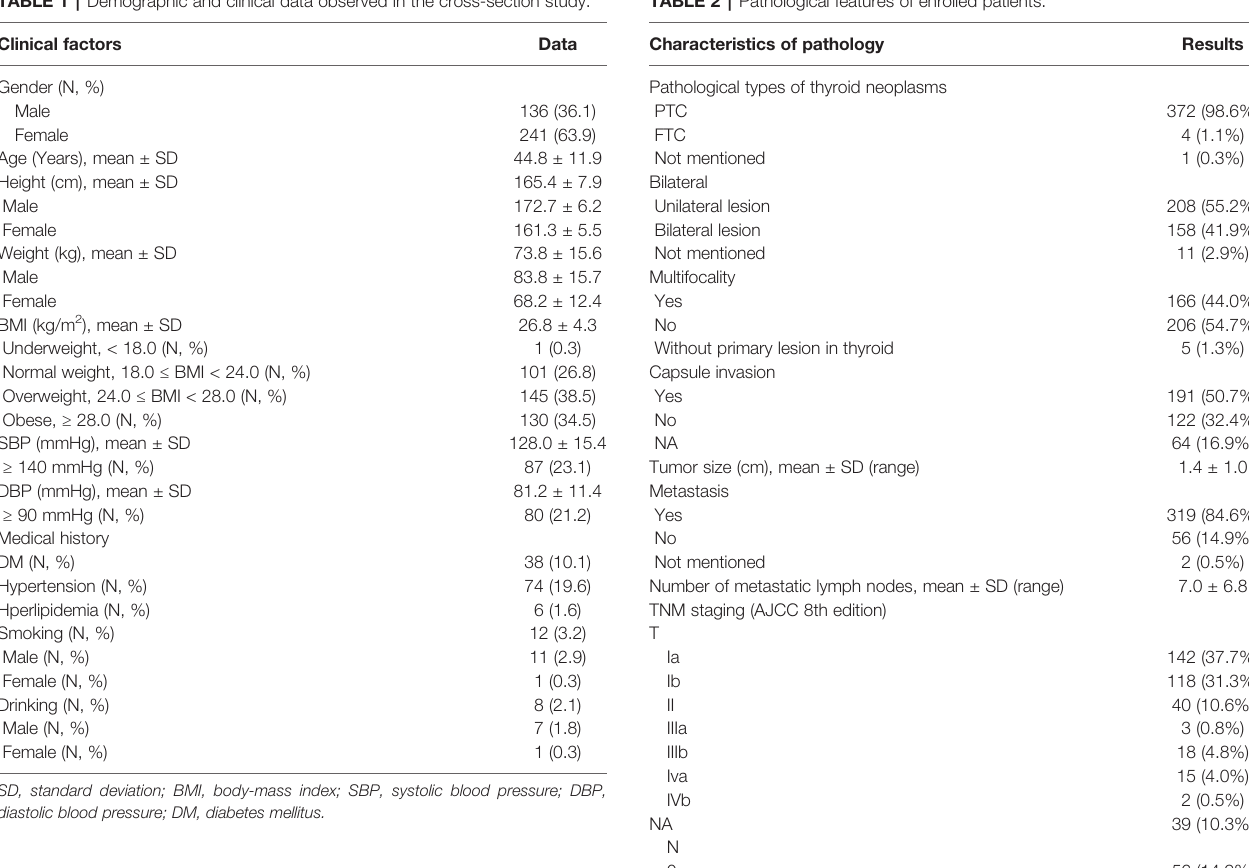
TABLE 2 | Pathological features of enrolled patients. TABLE 1 | Demographic and clinical data observed in the cross-section study.